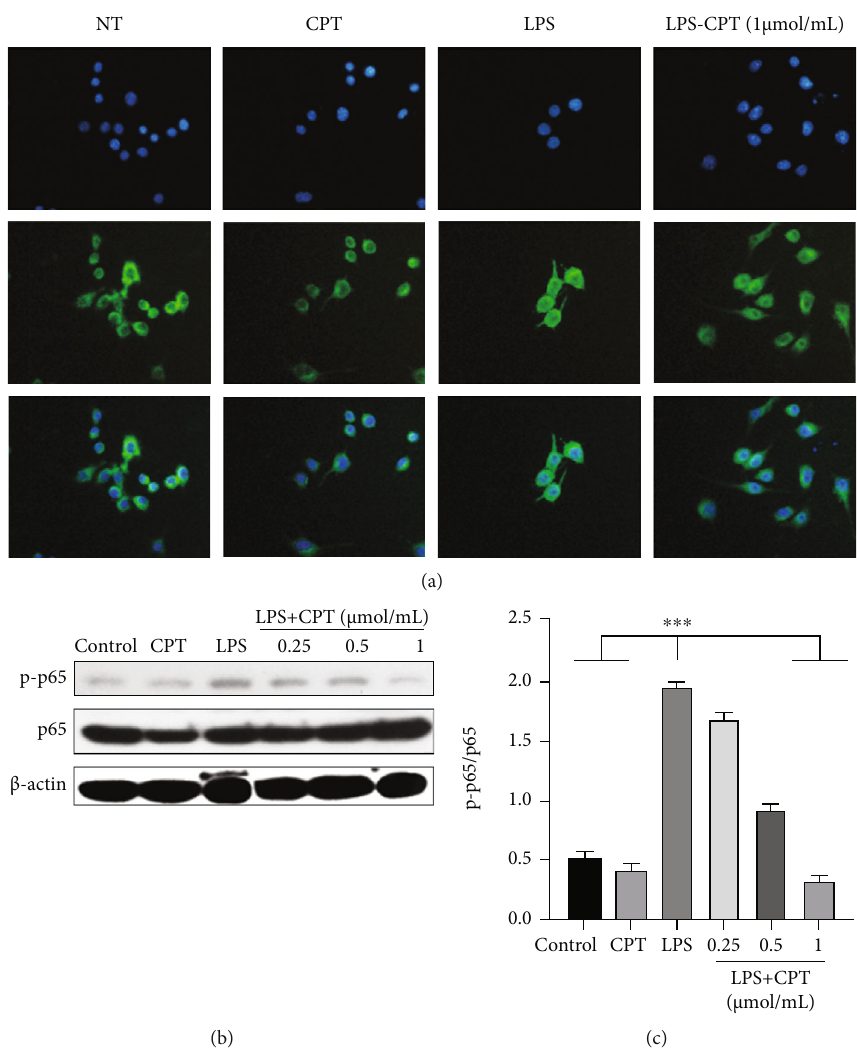
Figure 9: E ff ects of camptothecin (CPT) on the transcription factor p65 in the NF- κ B signaling pathway. RAW264.7 cells were induced by LPS, and the phosphorylation of p65 was assayed using immuno fl uorescence (a). Protein levels of p-p65 were detected by western blot and quantitatively assessed via densitometry using p65 as an internal control (b, c). The values presented are mean ± SD ( ∗ P < 0 : 05 , ∗∗ P < 0 : 01 , and ∗∗∗∗ P < 0 : 0001 vs.